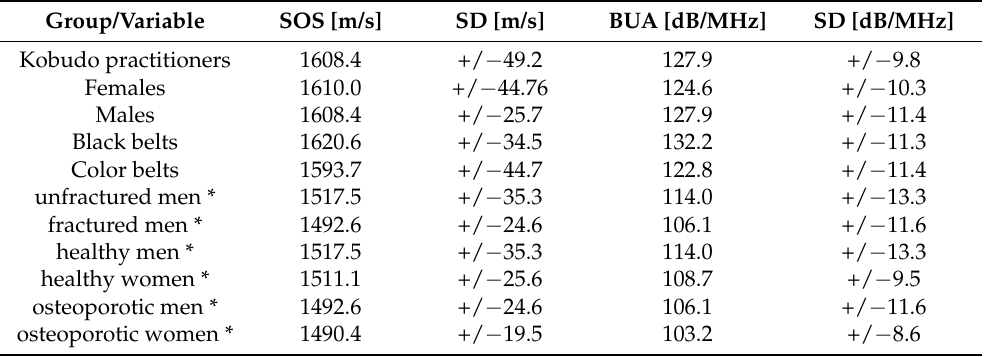
Table 4. Average values and standard deviations of SOS and BUA measured in the study group and values presented in the literature as characteristic for healthy, fractured, and osteoporotic subjects. * Comparison was based on measurement values presented in the literature